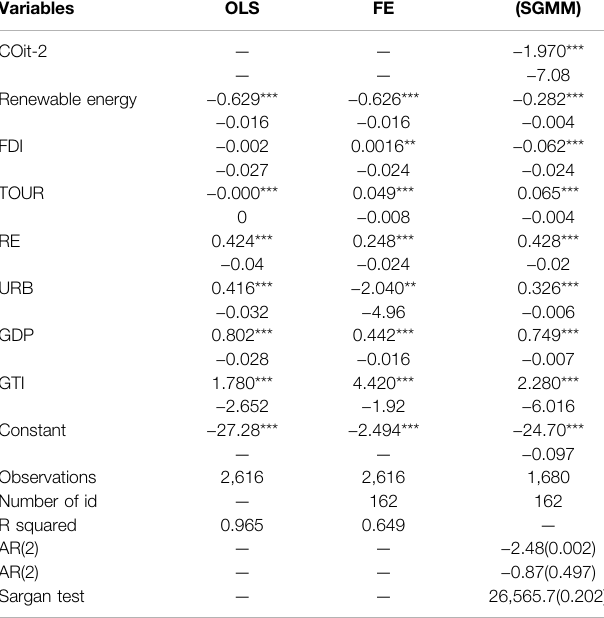
TABLE 3 | Results of OLS, fi xed effect, and system GMM